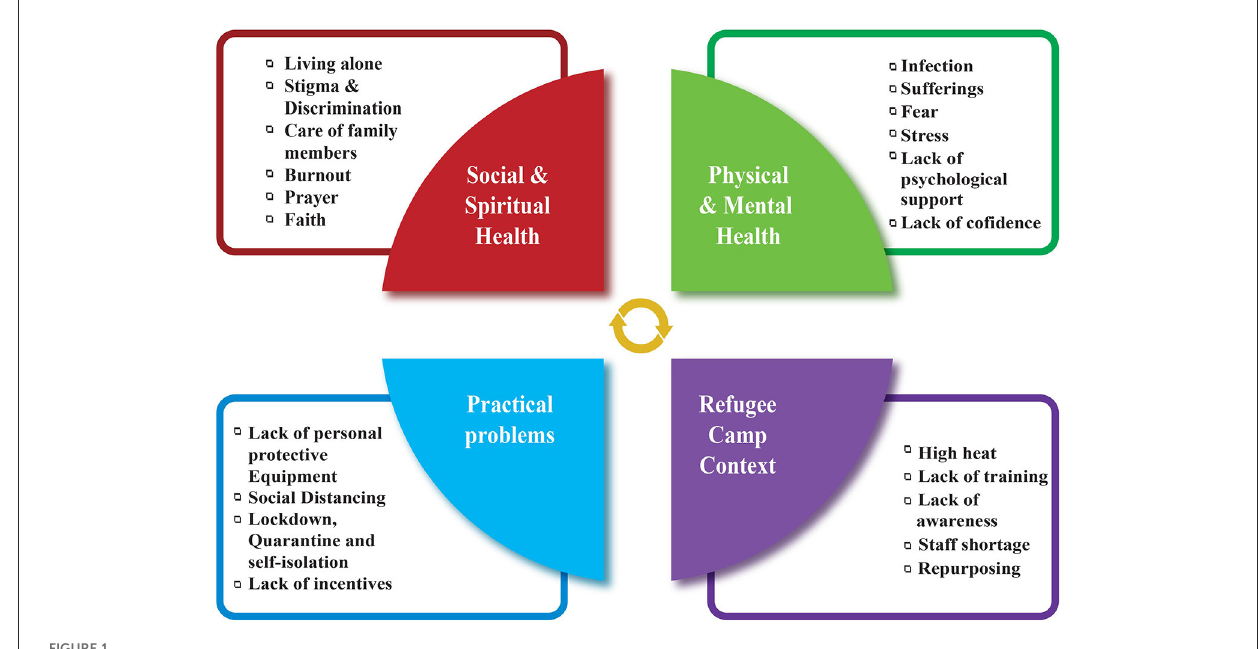
FIGURE1 Multidimensional factors related to COVID-19 that affects FHCWs.